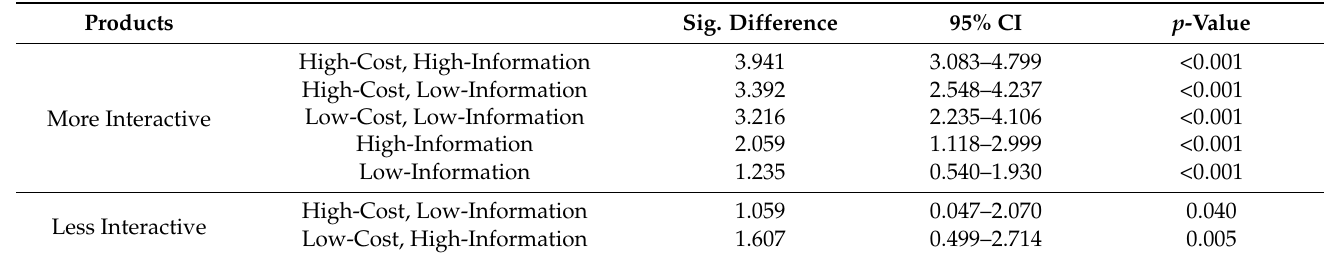
Table 2. Significant Differences—More Interactive/Less Interactive